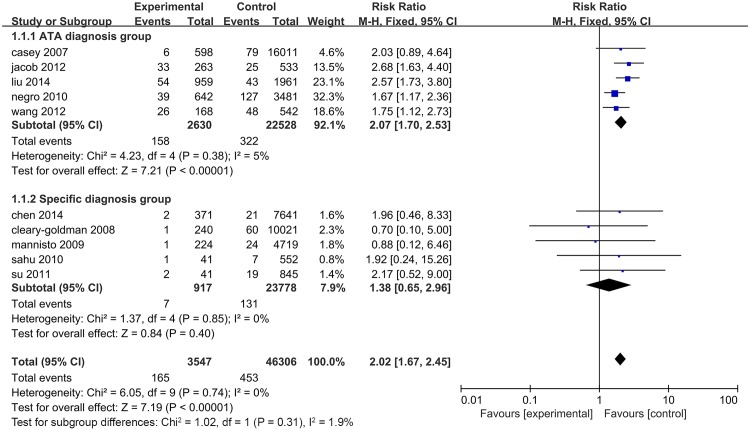
Forest plots for the prevalence of miscarriage risk in untreated SCH patients diagnosed with ATA criteria and specific criteria compared with control(data in forest plots were from the study of Maraka et al.)